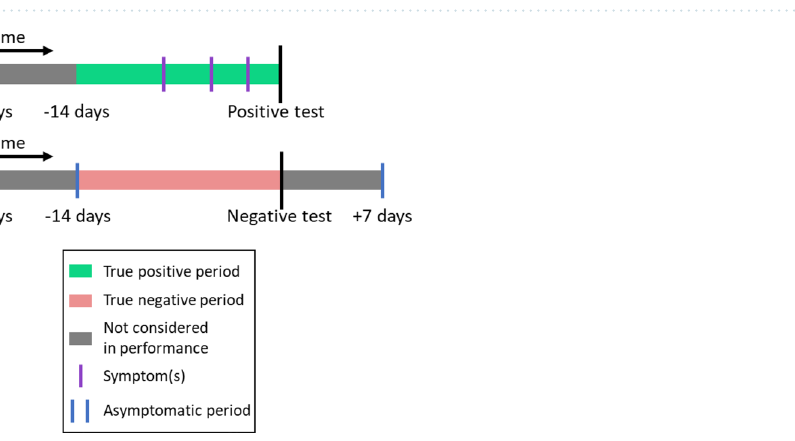
Figure 4. Graphical summary of definitions for positive and negative